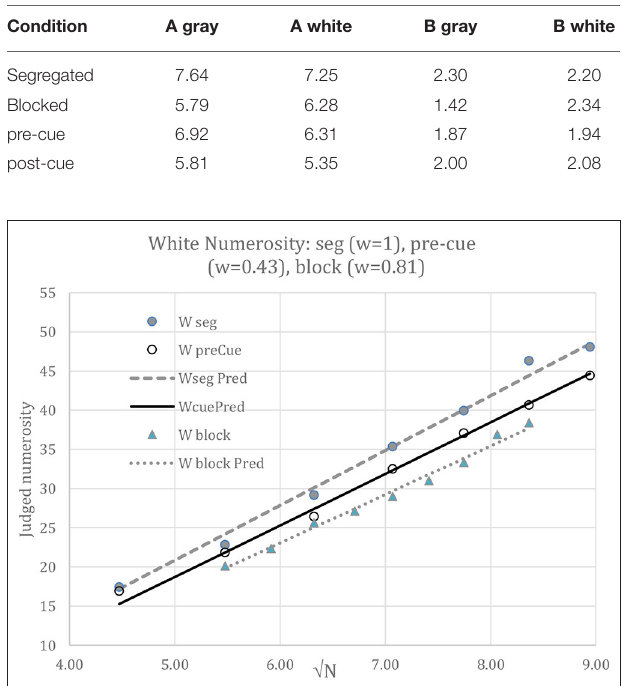
FIGURE 8 | White numerosity when segregated (“seg”), as predicted by Equation 2, and when intermingled and either pre-cued or blocked, as predicted by Equation 3. Data are shown by dots and predictions by straight lines. Parameters A 7.00, B 2.02 were first fit to judgements of the = = segregated W disks. Parameters w 0.43 and w 0.81 were then best fit to = = judgements of the pre-cued and blocked intermingled W disks, with A and B unchanged. The different weights in different conditions of attention illustrate how attention can be captured in the model expressed by Equation 3. However, direct evidence that attention can alter the effective contrast energy that underpins the numerosity illusion is lacking, so this finding remains suggestive rather than conclusive; further evidence would be required to confirm